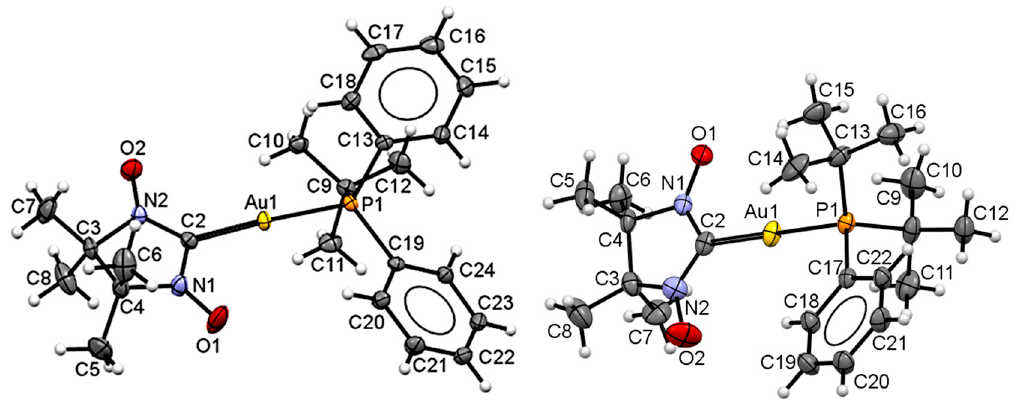
Figure 3. ORTEP view and the atom numbering scheme of NN-Au-P t BuPh 2 ( 1 ) and NN-Au-P t Bu 2 Ph ( 2 , one of two independent molecules) with displacement ellipsoids at a 50% probability level.